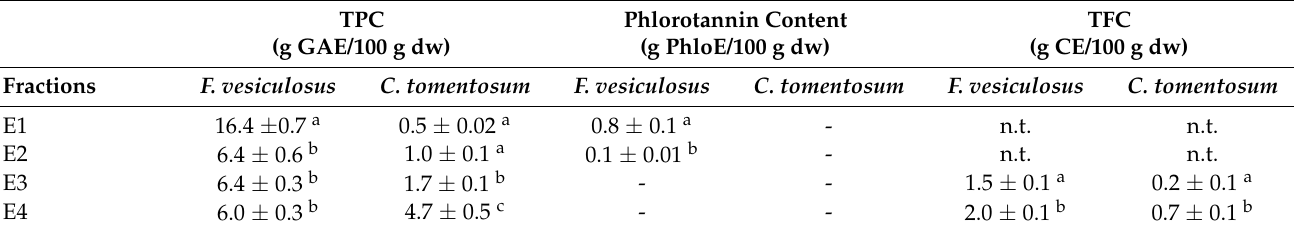
Table 4. Phenolic and phlorotannin contents of SWE extracts (mean ± SEM). TPC (g GAE/100 g